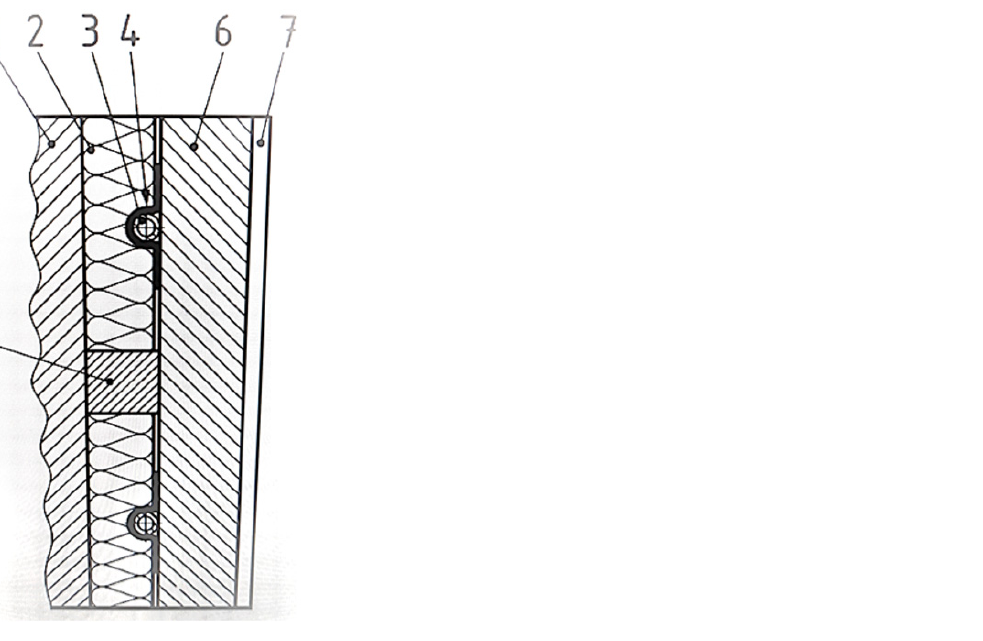
Figure 5. Wall system with pipes in the insulation layer with thermal diffusion devices, type B (STN EN 1264-1). 1—wall structure, 2—insulation layer, 3—piping, 4—thermal diffusion device, 5—fixing supports, 6—thermal diffusion layer, and 7—surface covering.